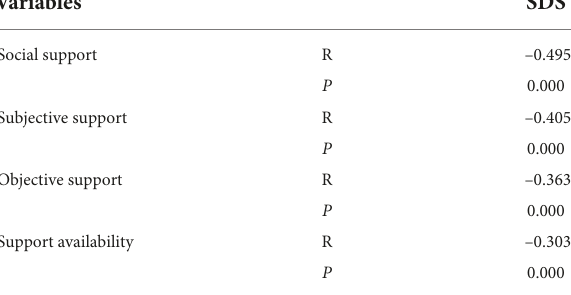
TABLE 4 Correlation analysis between patients’ social support and SDS